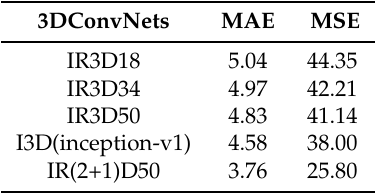
Table 3. The results of different 3D ConvNets on the